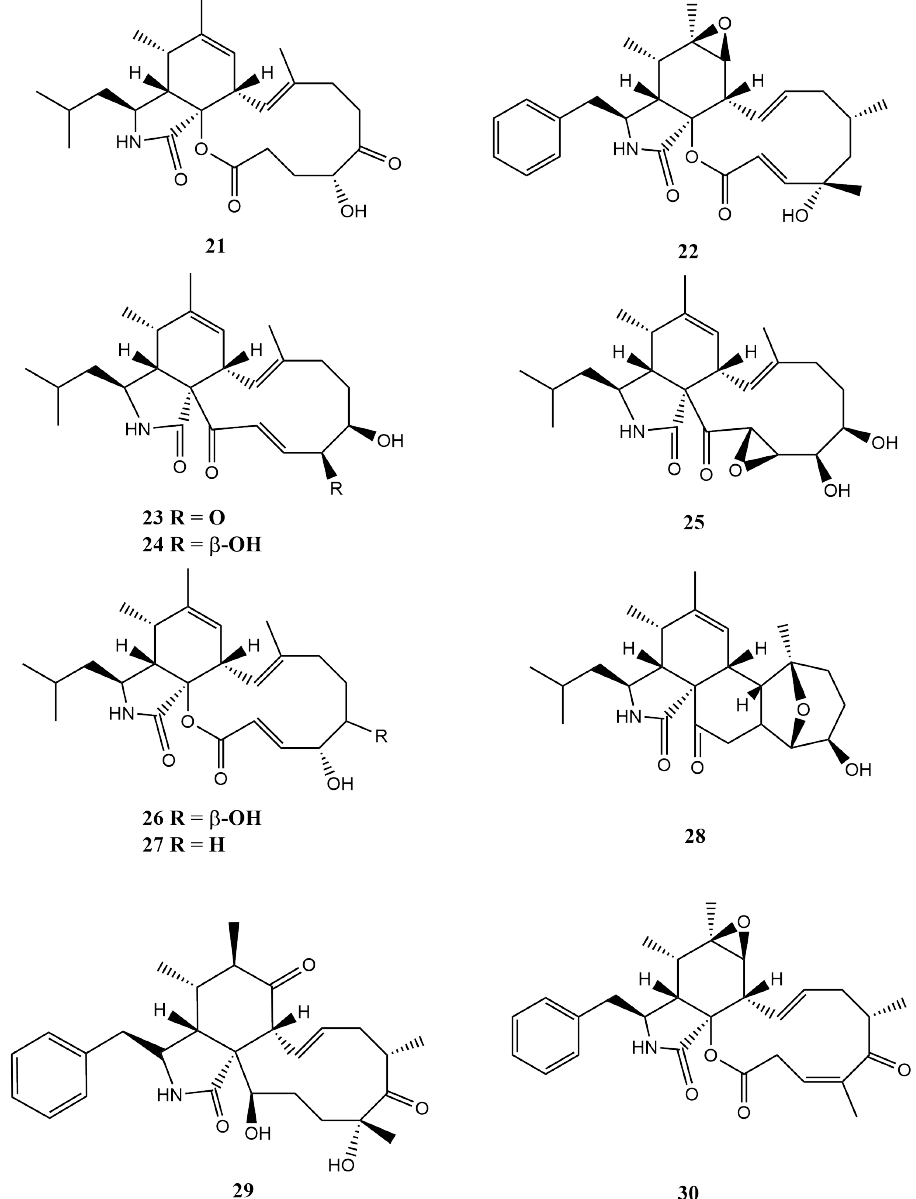
Figure 2. The chemical structures of the types of indole alkaloids isolated from the soft-coral- associated fungi. The compounds 3,3 (cid:48) -diindolyl(phenyl)-methane ( 36 ) and 1,1-(3,3 (cid:48) -diindolyl)-2- phenylethane ( 37 ) were reported from the bacteria Edwardsiella tarda [85]. 3,3 (cid:48)